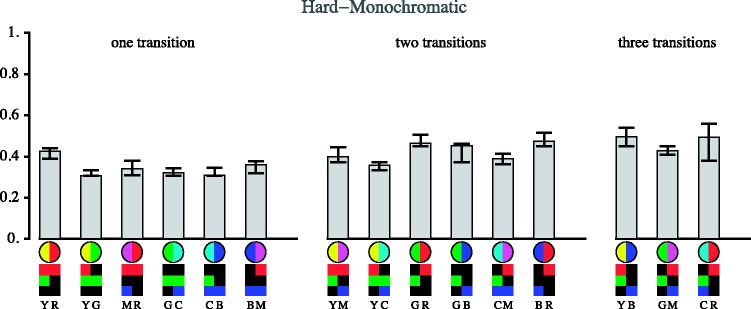
Normalised data for the hard monochromatic condition as quartiles over observers as bar plots for the various colour pairs. The transition structures are illustrated in Figures B1 and B2. The bars show quartile values of the distinctiveness settings for all observers.